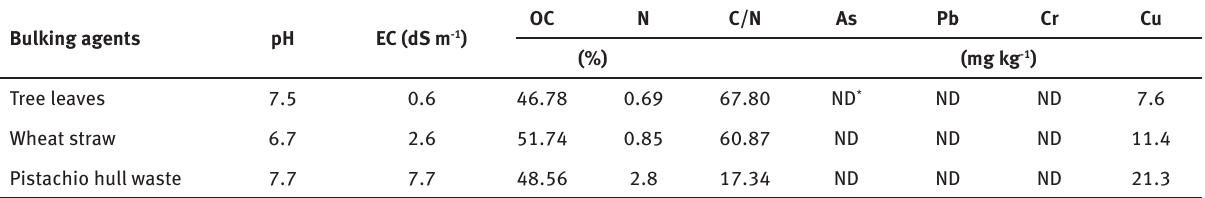
Table 2: Chemical properties of bulking agents used in current study.